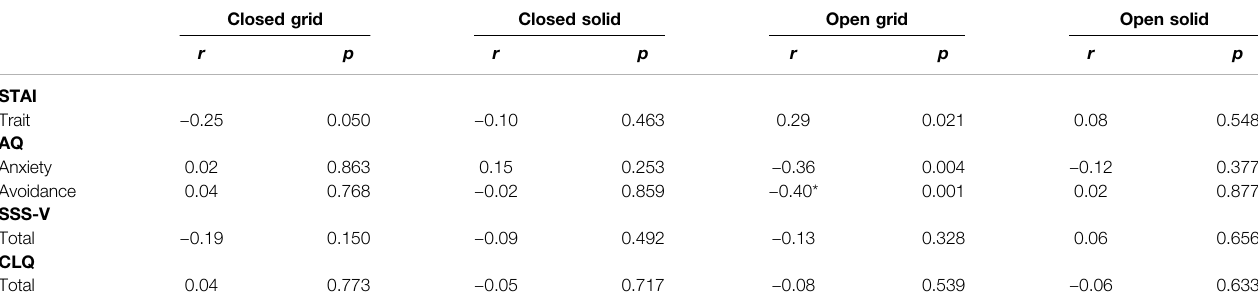
TABLE 4 | Results of correlation analyses of time spent on various maze arms and psychometric questionnaires. Closed grid Closed solid Open grid Open